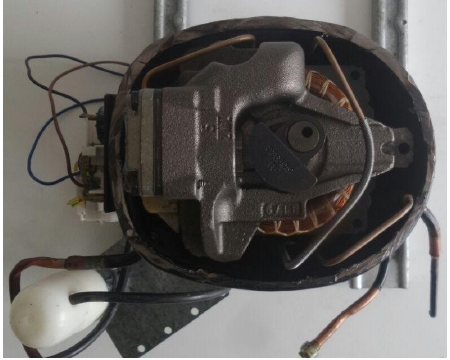
Figure 10. The photograph of the freezer motor (top view).